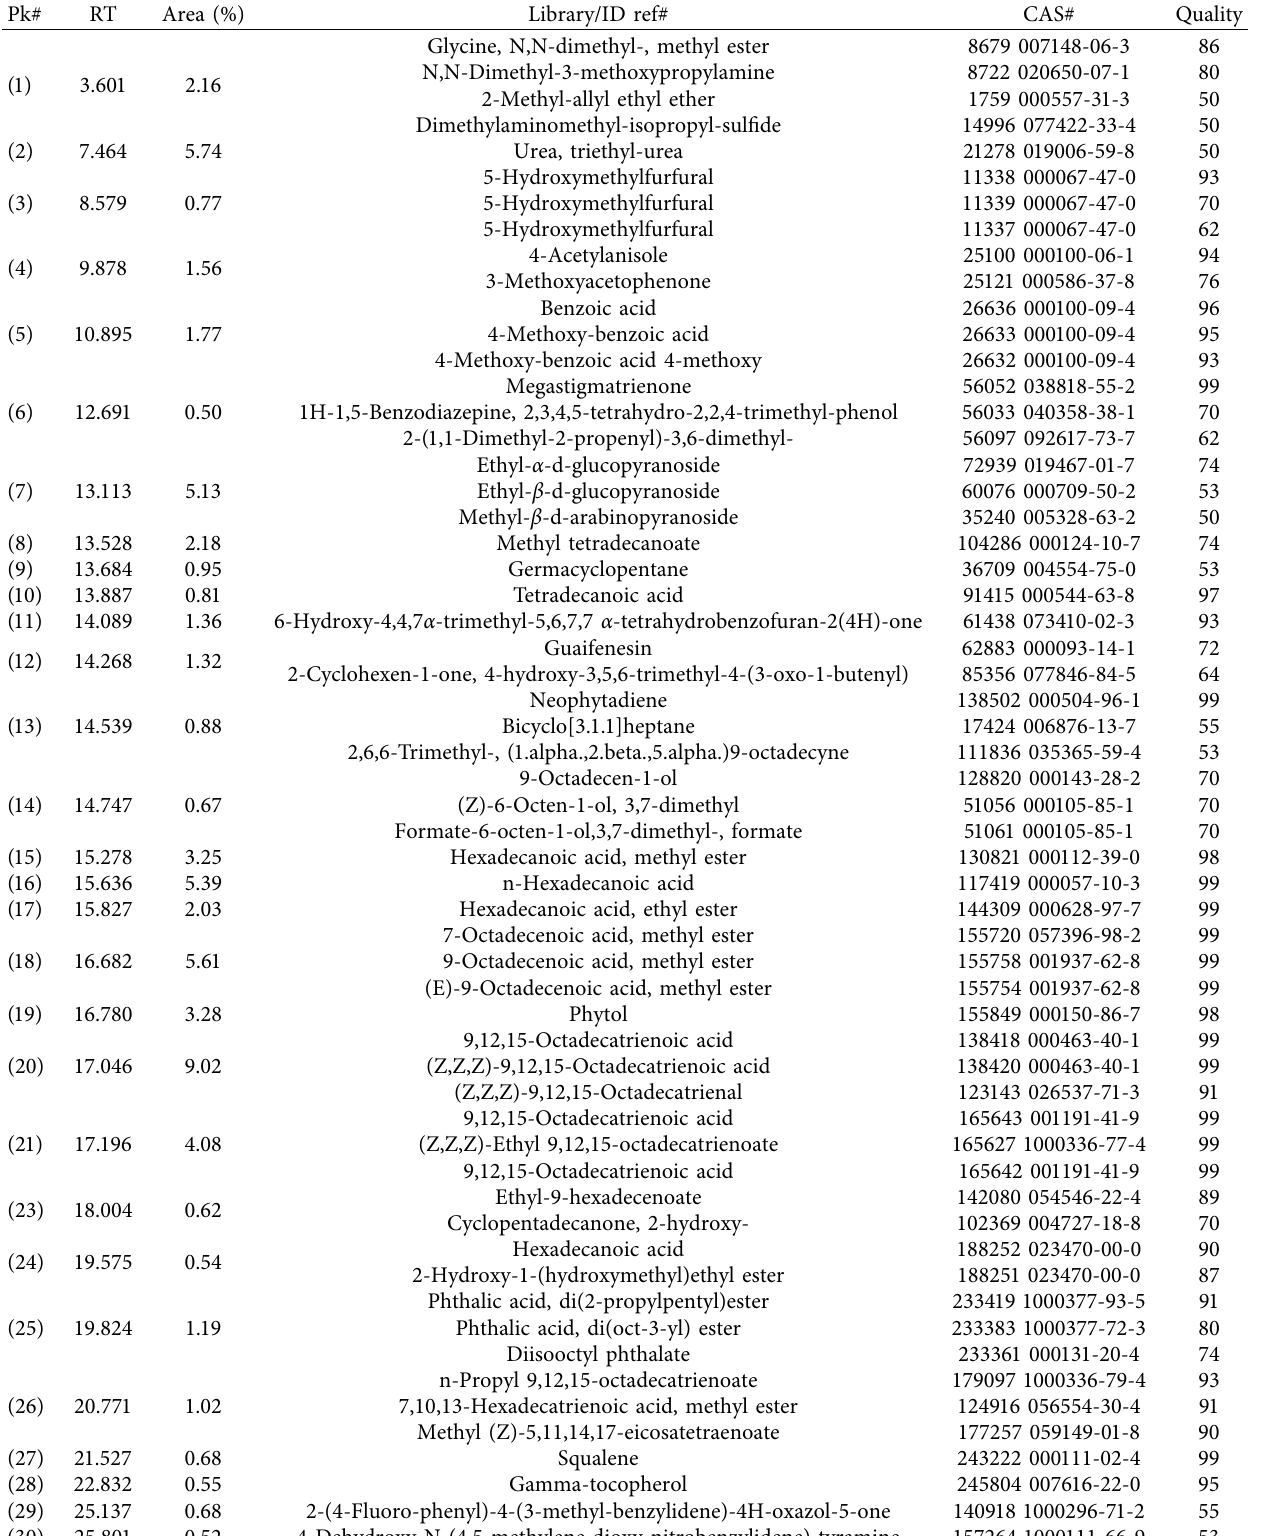
Table 3: Quantitative analysis of the secondary metabolites (PhytoScan) of the Clerodendrum volubile ethanol leaf extract ( CVE ) using gas chromatography-mass